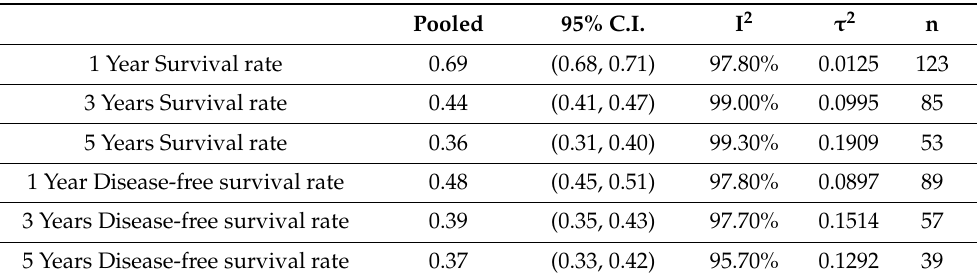
Table 2. Results of random effects meta-analyses for 1, 3, 5 years survival rates and 1, 3, 5 years disease-free survival rates.